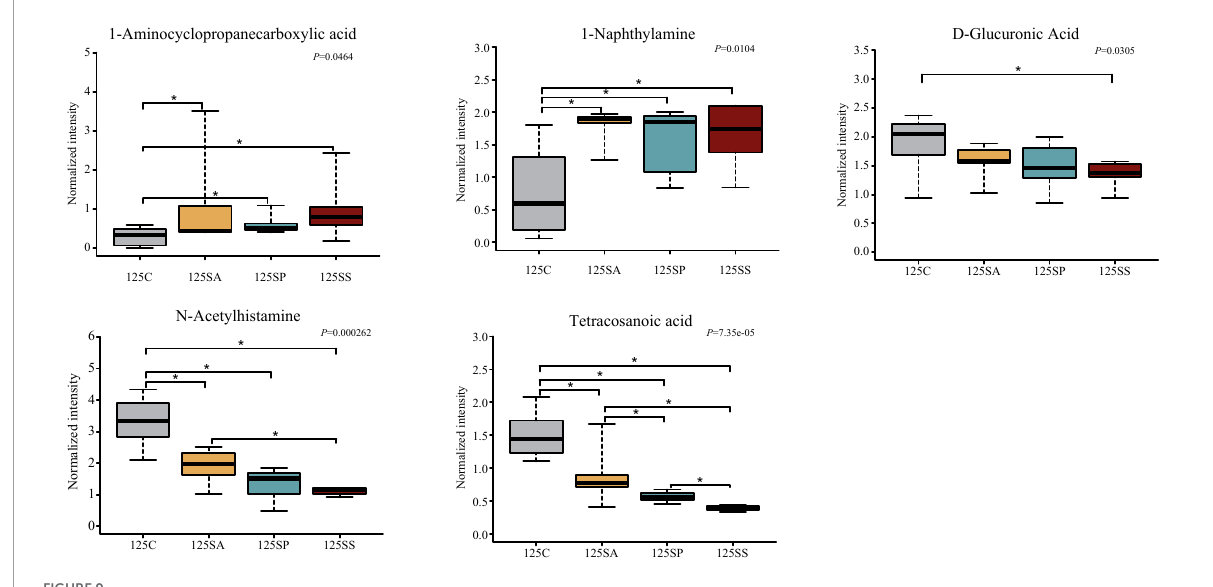
FIGURE9 The box plots of different metabolites at 125 days of age. Asterisk represents P < 0.05. 125C, sow fed with basal diet; 125SA, sow fed with antibiotic; 125SP, sow fed with probiotics; 125SS, sow fed with synbiotics.